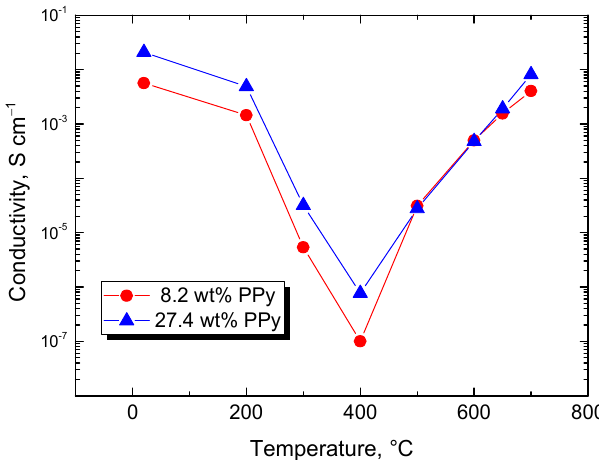
Figure 12. Conductivity of the polypyrrole-coated sponge exposed to various temperatures deter- mined at 0.1 MPa pressure. The low conductivity of sponge with 8.2 wt% polypyrrole exposed to 400 °C was estimated separately by a two-point method.